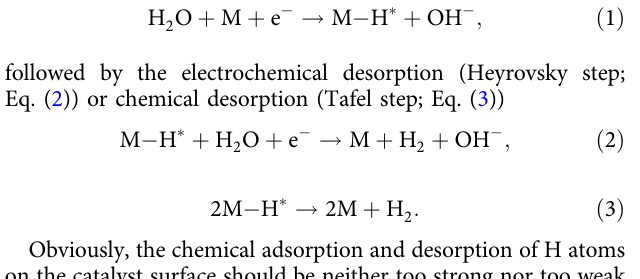
Supplementary Fig. 10b, the Tafel slope of the Co-substituted Ru